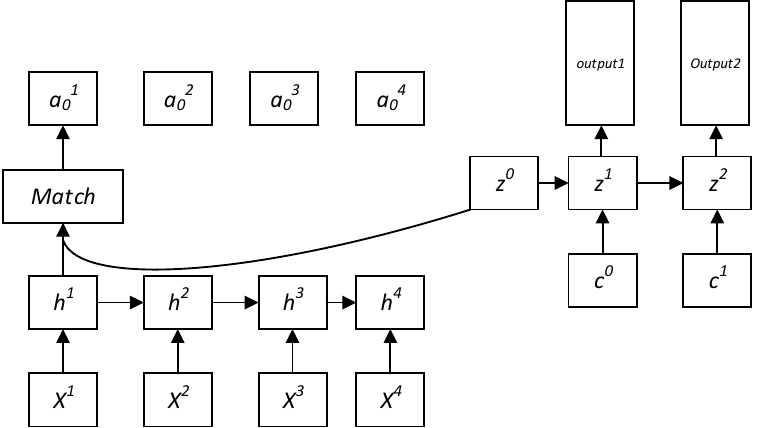
Figure 11. The structure of the implementation of the attention mechanism.